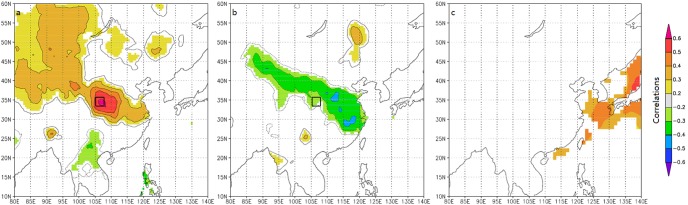
Correlations field maps.(a) Reconstructed May–June maximum temperature of Tianshui and the gridded May–June maximum temperature for the period 1953–2008. (b) Reconstructed May–June maximum temperature of Tianshui and May–June cloud cover for the period 1953–2008. (c) Reconstructed May–June maximum temperature of Tianshui and October–June SSTs for the period 1940–2008.